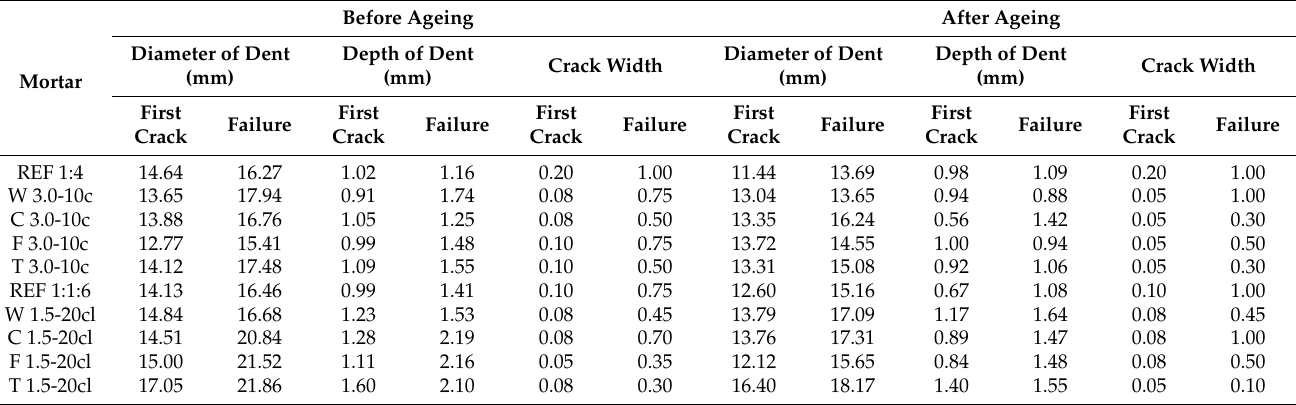
Table 3. Impact dent characteristics and cracking